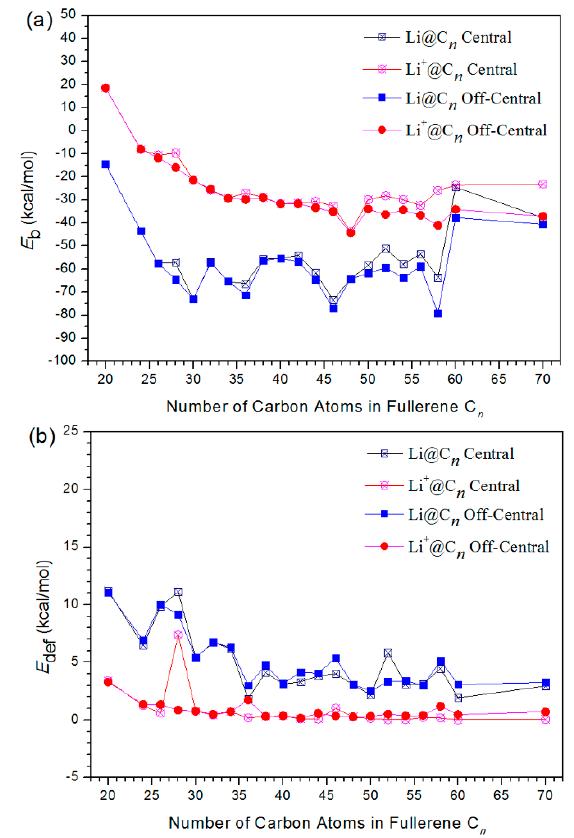
Figure 2. Binding energies ( a ) and deformation energies ( b ) of Li@C n and Li + @C n.